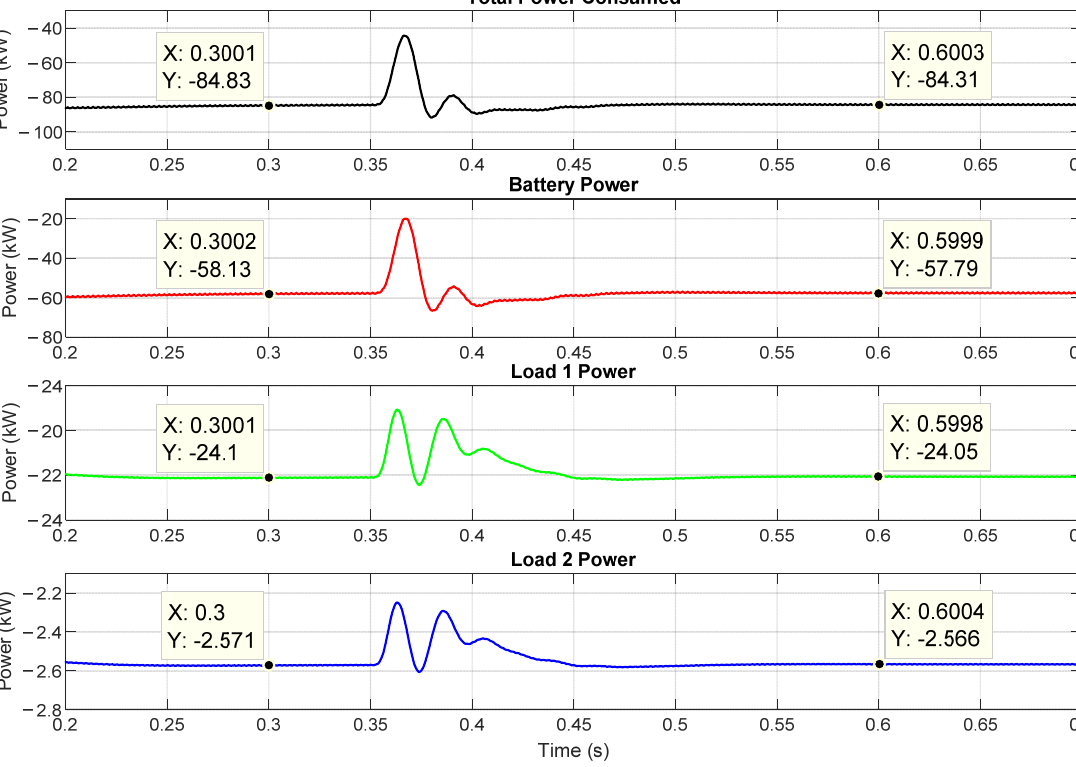
Figure 15. Total power consumed and the share of battery, load 1 and load 2, before and after the step change.